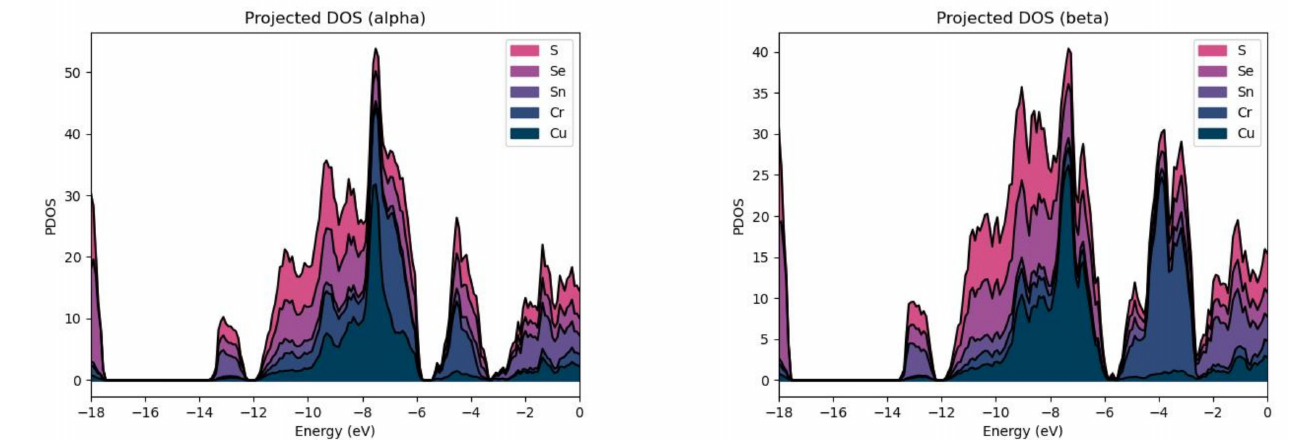
Figure 4. Element and spin-resolved density of states for the model CuCrSnS 2 Se 2 . Remaining systems are presented in Figure